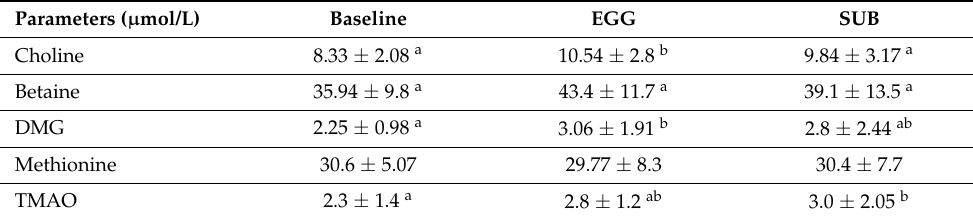
Table 6. Plasma choline and metabolites from fasting plasma of MetS participants (n = 24) at baseline and after EGG or SUB diet for 4 weeks each